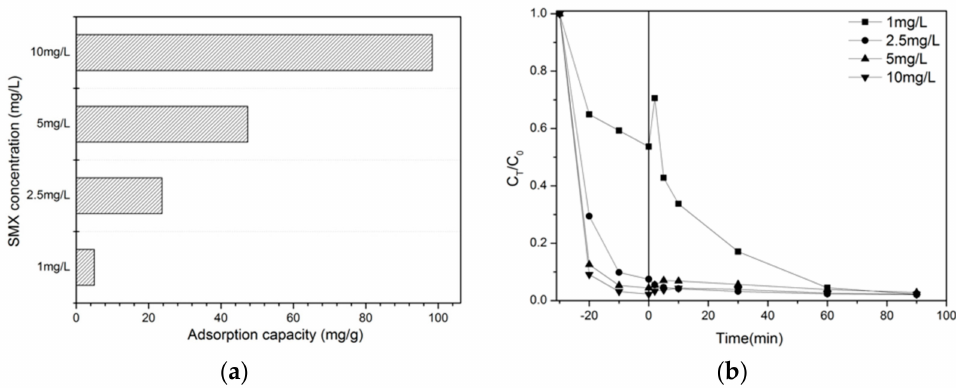
Figure 4. ( a ) Adsorption capacity of Ag@Ag 2 O-G2 for different SMX concentrations in the darkand ( b ) adsorption capacity and the photocatalytic activities of Ag@Ag 2 O-G2 for different SMX concentrations removal under visible light (C catalyst = 0.05 g/L).